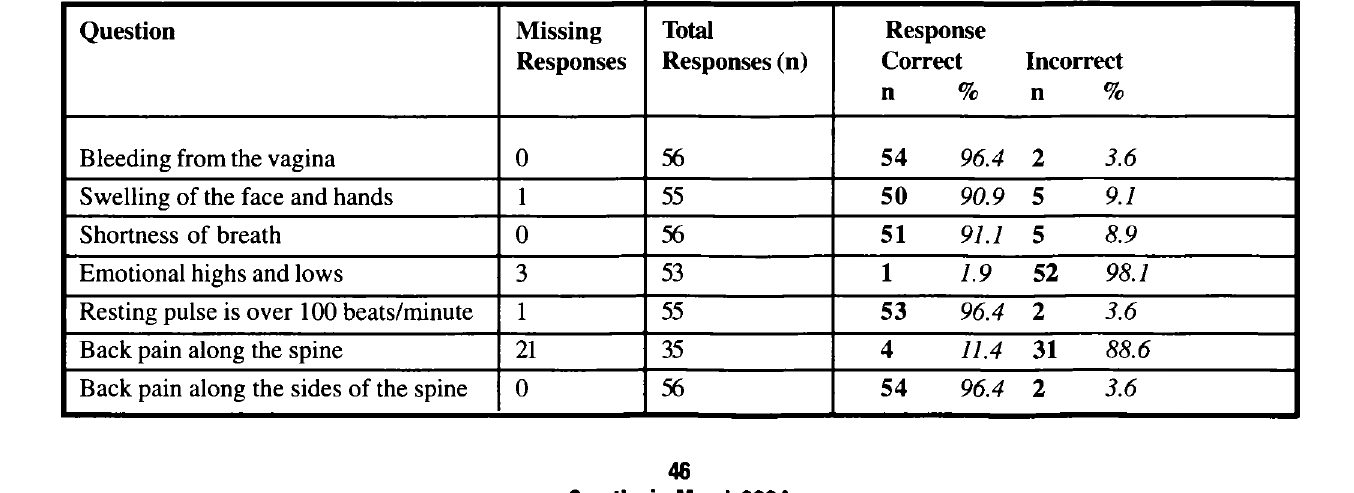
Table 3: Knowledge assessment: Risk factors for the mother during pregnancy Question Missing